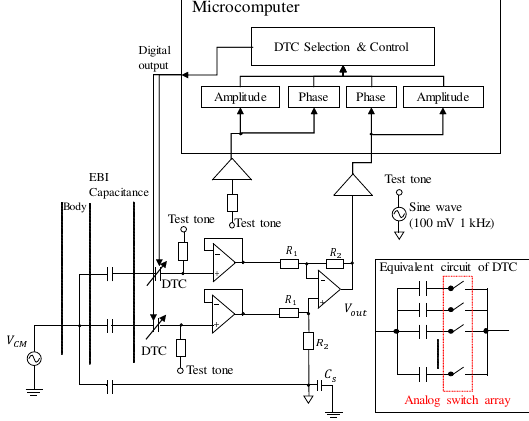
Figure 10. Configuration of the imbalance cancellation system with a